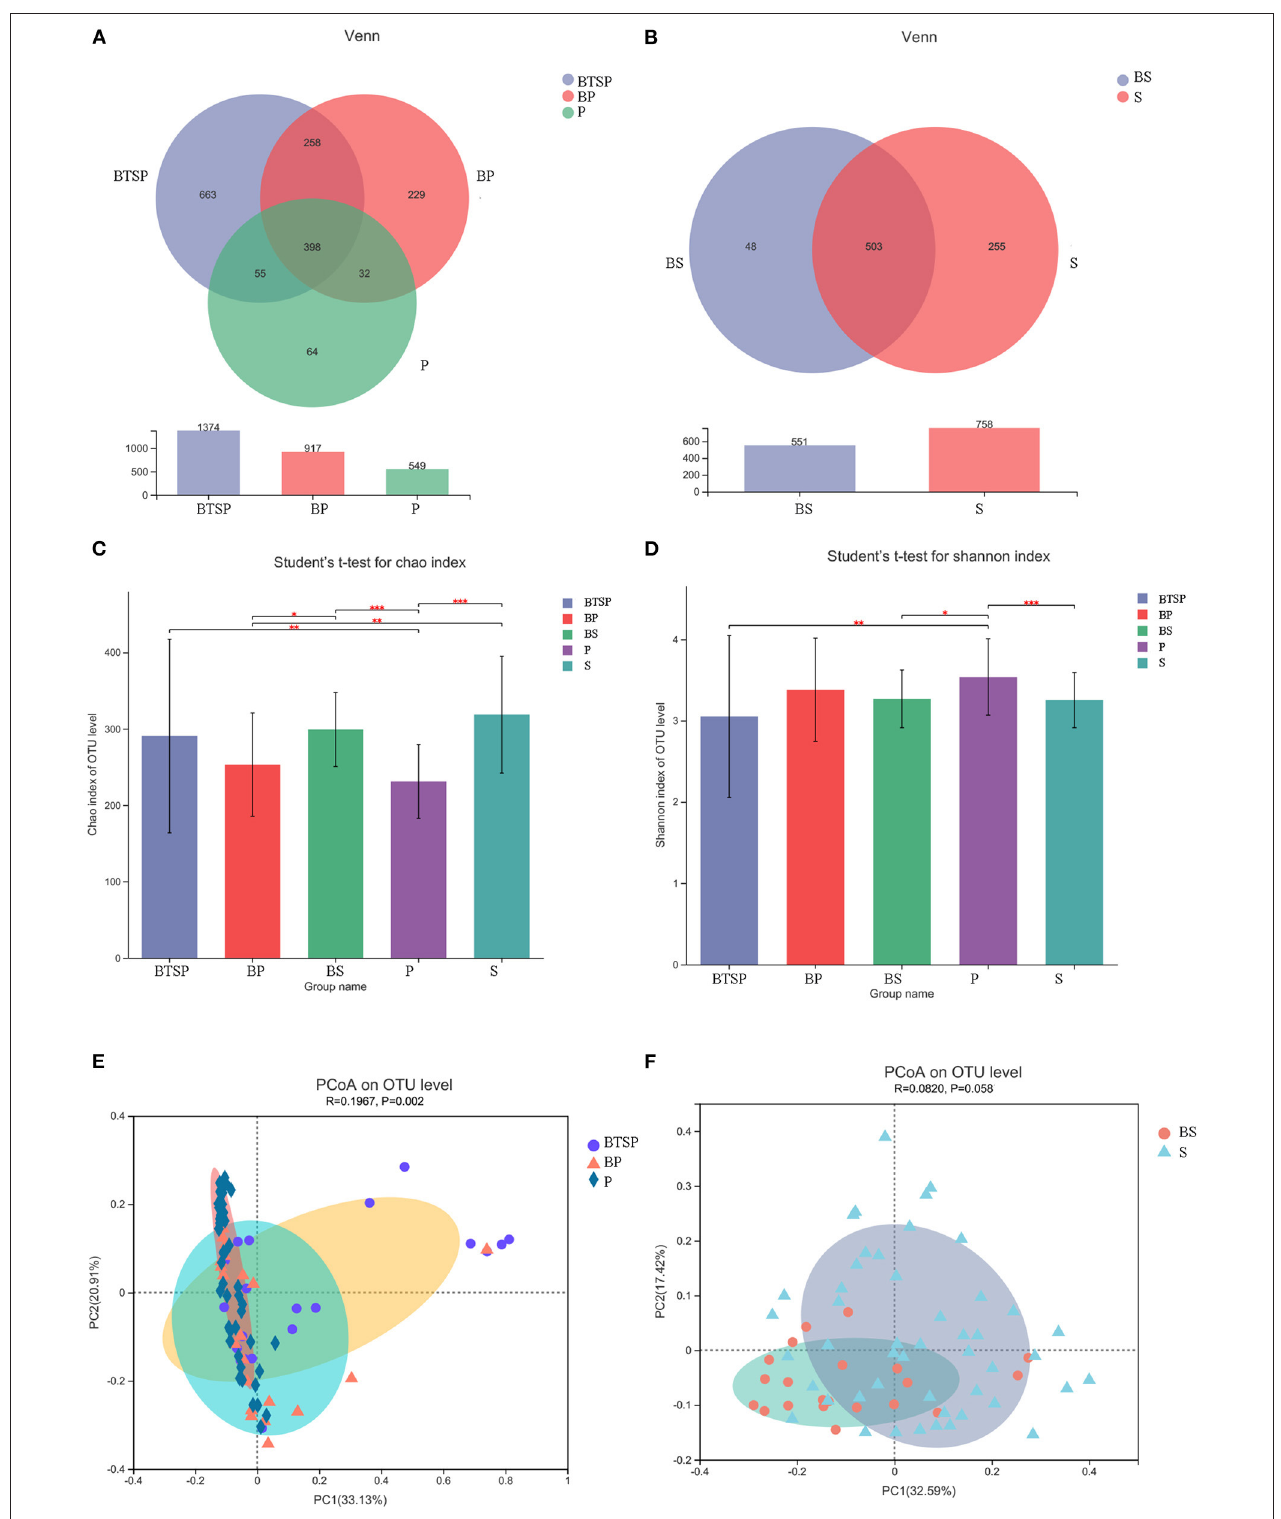
FIGURE 1 | Characteristics and diversity of saliva and plaque microbiota. (A) Venn diagram depicting OTU distributions of plaque samples. (B) Venn diagram of saliva samples. (C) Chao index comparing the α diversity; * P < 0.05, ** P < 0.01, *** P < 0.001. (D) Shannon index; * P < 0.05, ** P < 0.01, *** P < 0.001. (E) PCoA showing the differences in the plaque microbiome community structure based on the weighted normalized UniFrac distance with ANOSIM analysis. (F) PCoA of the saliva microbiome.